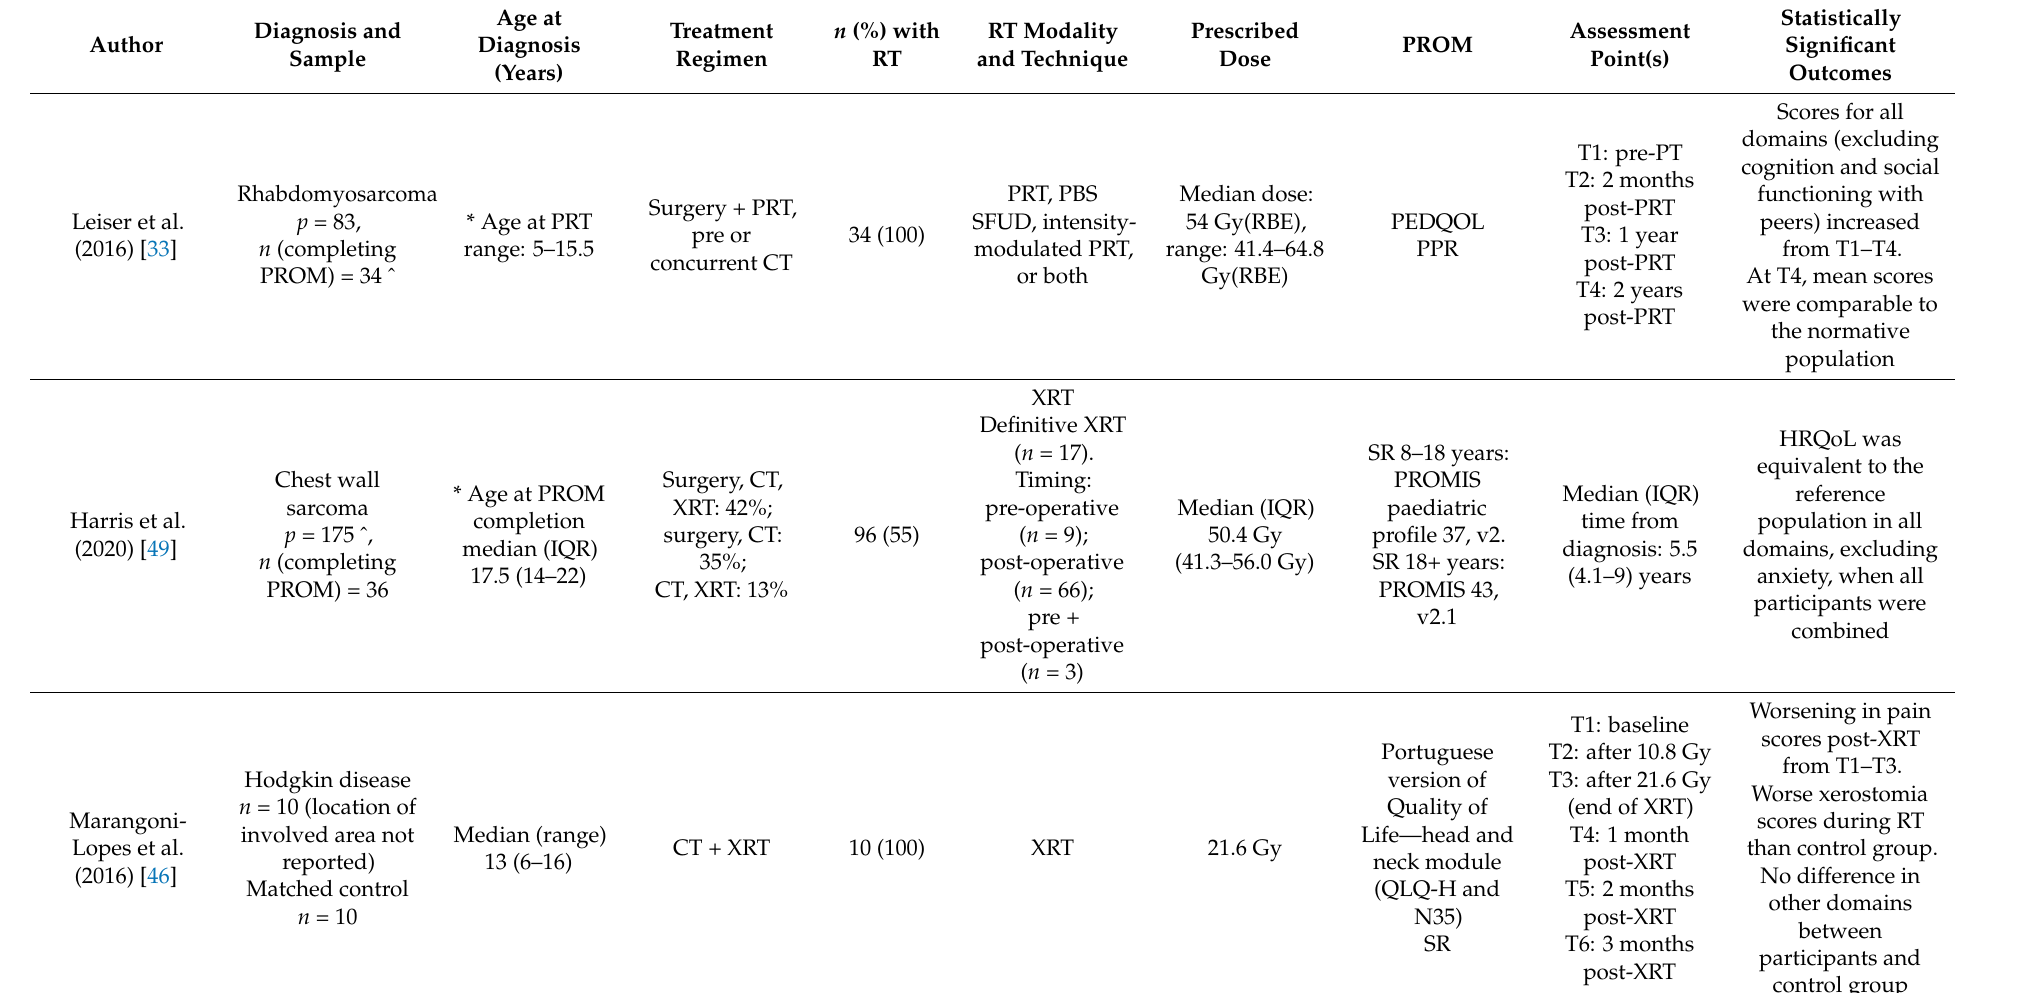
Table 3. Health-related quality of life in survivors of non-central nervous system tumours (photon and